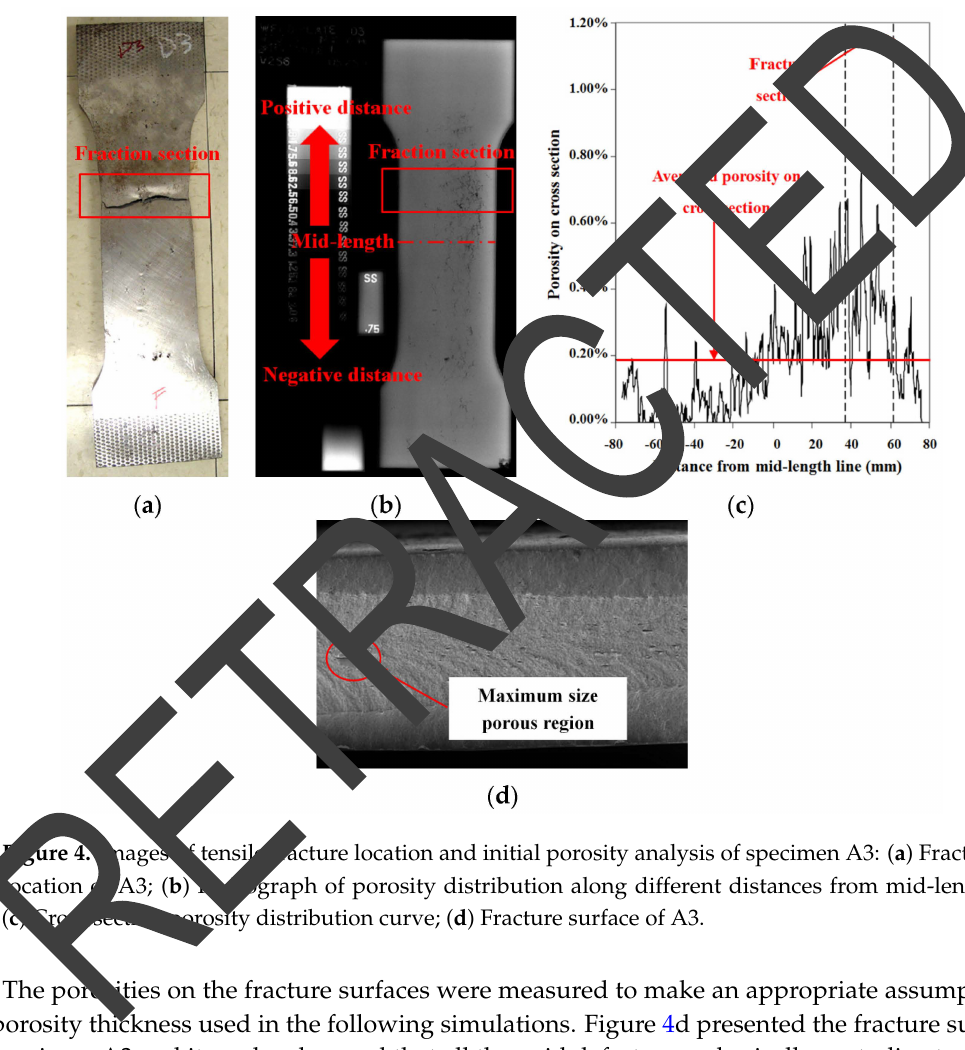
Figure 4. Images of tensile fracture location and initial porosity analysis of specimen A3: ( a ) Fracture location of A3; ( b ) Radiograph of porosity distribution along different distances from mid-length; ( c ) Cross section porosity distribution curve; ( d ) Fracture surface of